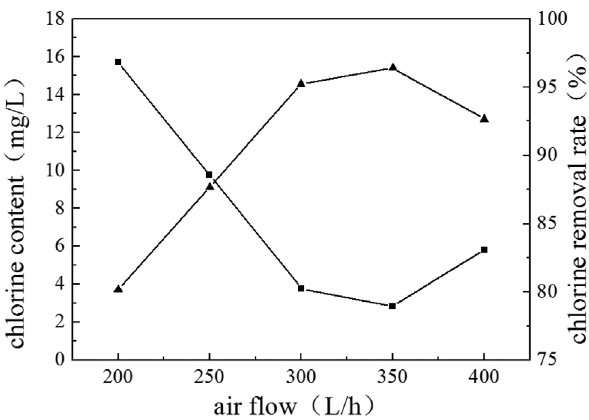
Fig. 9: Effect of air flow rate on chlorine content and Cl removal